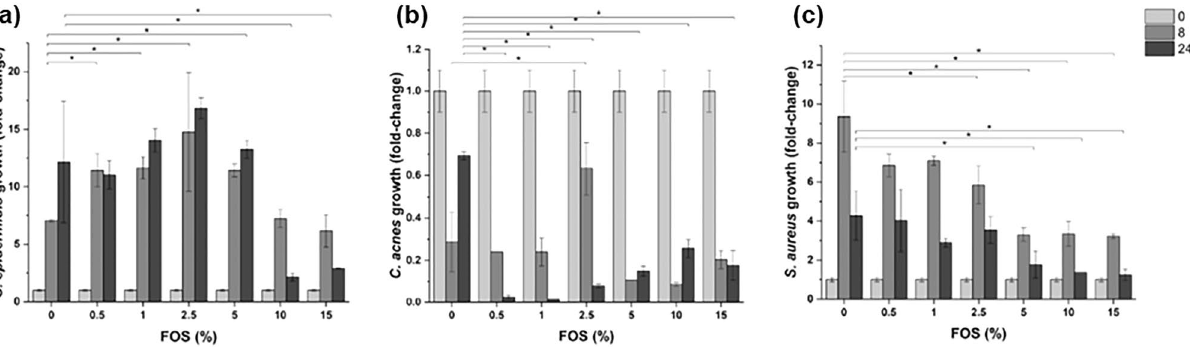
Figure 1. ( a ) S. epidermidis , ( b ) C. acnes and ( c ) S. aureus growth following exposure to different concentrations of scFOS at 0 (light grey column), 8 (grey column) and 24 h (dark grey column) in minimal